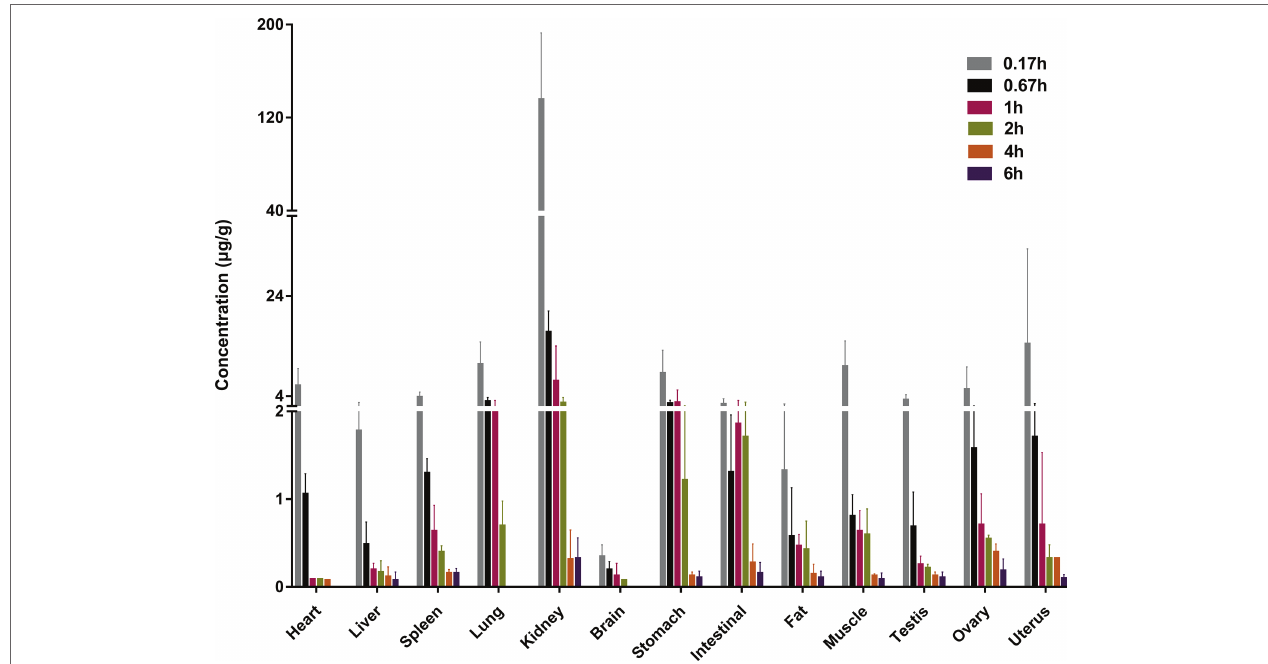
FIGURE 3 | Tissue concentration of sodium danshensu at different time points after intravenous administration of 30 mg/kg in